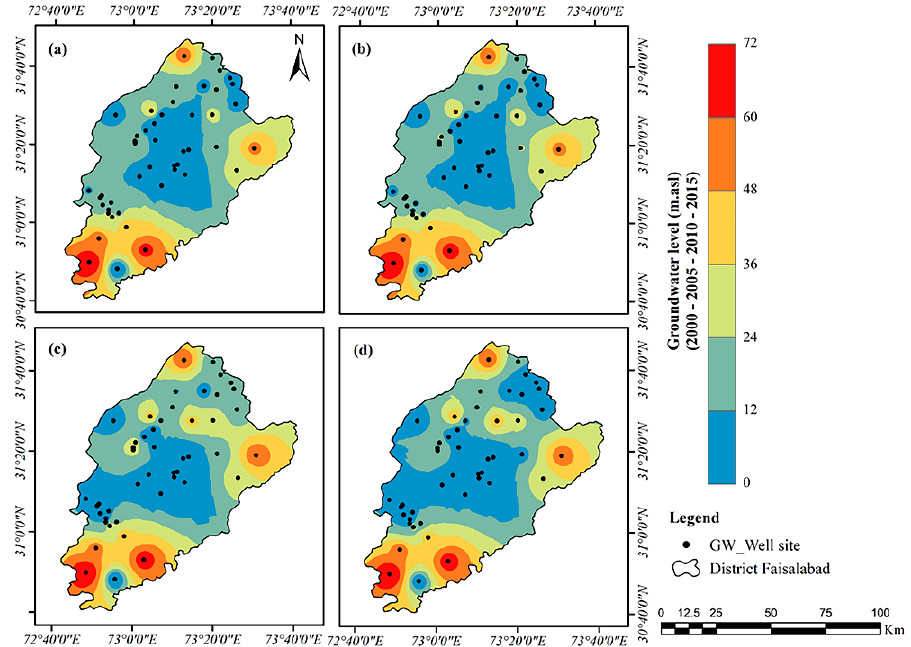
Figure 6. Spatial pattern of annual average groundwater level in 2000 ( a ), 2005 ( b ), 2010 ( c ), and 2015 ( d ).